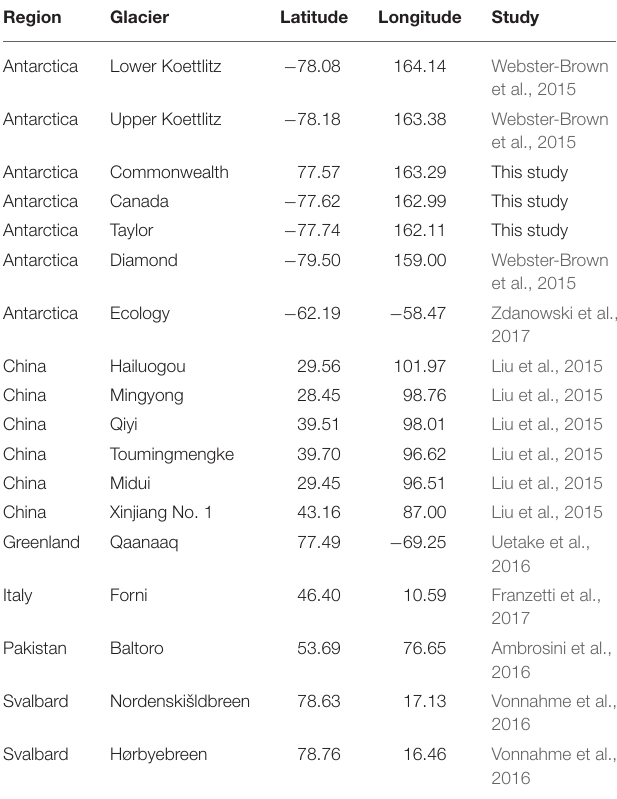
TABLE 1 | Locations of